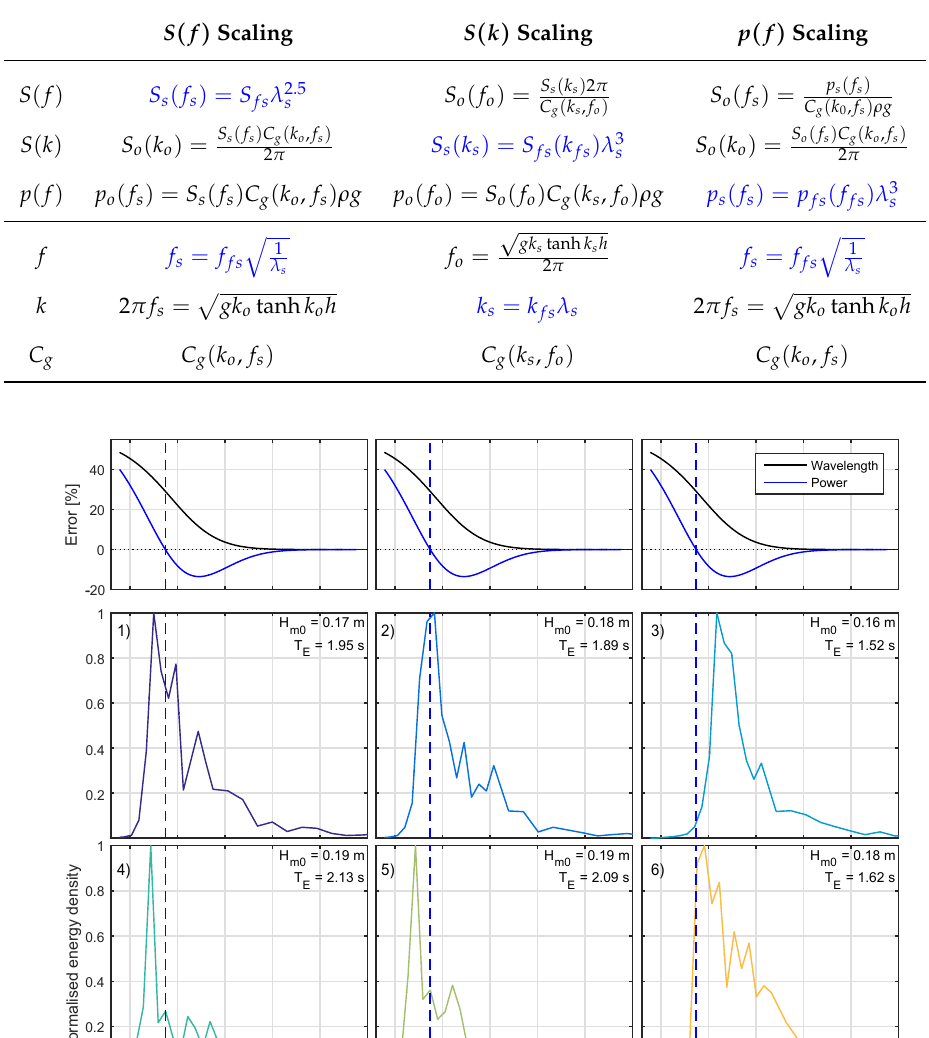
Table 2. Effect of various scaling approaches on other parameters (guaranteed Froude scaled parameters shown in blue).